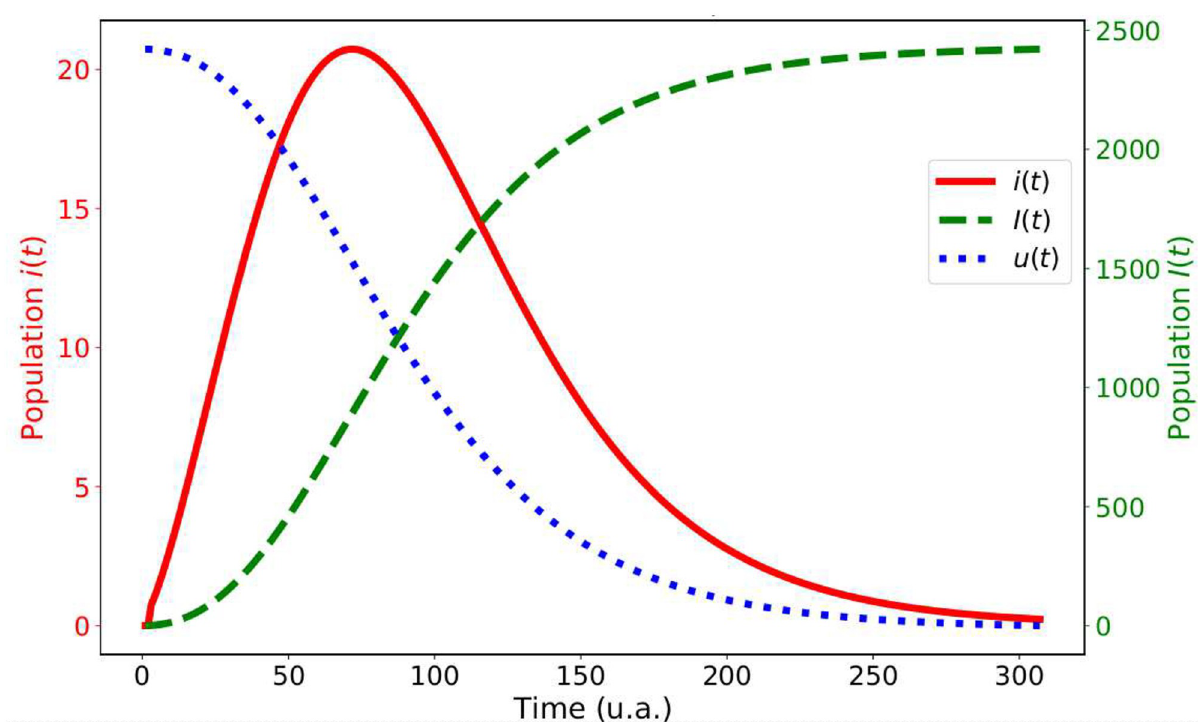
Fig 2. Plots of the uninformed (dotted blue line), informed (dashed green line) and newly informed populations (continuous red line), according to the fractal dynamics for the information spread.